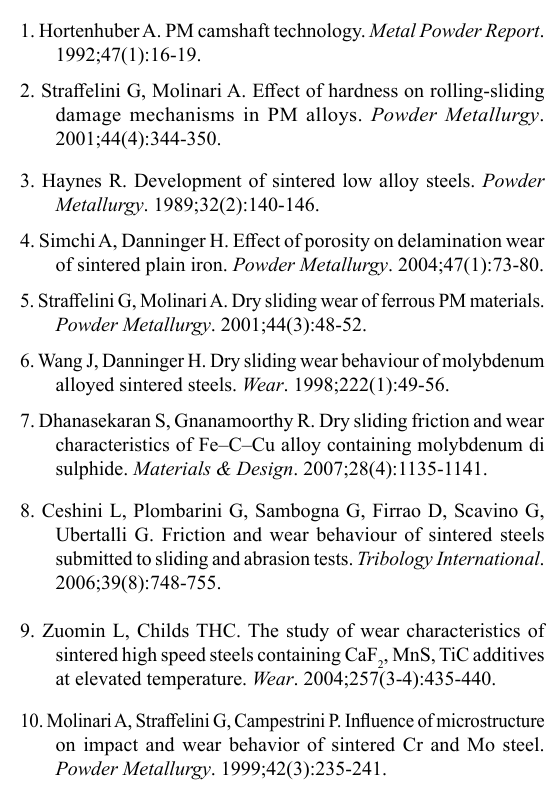
temperature 14 . The fracture of this oxide layer and WTiC act as a third body which is trapped between the mating surface further lead to formation of wear fragments results in higher mass loss during the wear test 15